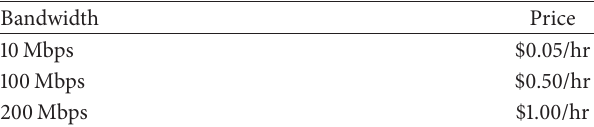
Table 6: Network bandwidth prices.